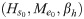
Boxplot identifiability analysis for models (1)–(3).Parameters of each model were ordered from lowest to highest identifiability. The black point represents the value of each parameter for the best estimation (best fit for the dengue real data of Bello municipality). We removed the outliers using the MATLAB function filloutliers and normalized the data with respect to the estimation interval for each parameter before plotting. Almost the same parameters (Hs0,Me0,βh) are unidentifiable for all three models. However, the initial condition of the aquatic stage of the vector (A0) is not identifiable for model (2), while the transition rate of humans (θm) and the initial condition of the recovered humans (Hr0) are less identifiable for model (3). It is noticeable that the best estimation for vector-human transition rate (βh) from models (1) and (2) corresponds to an outlier. Also, most of the highly identifiable parameters for the three models are attached to the inferior or superior bound of the estimation interval.